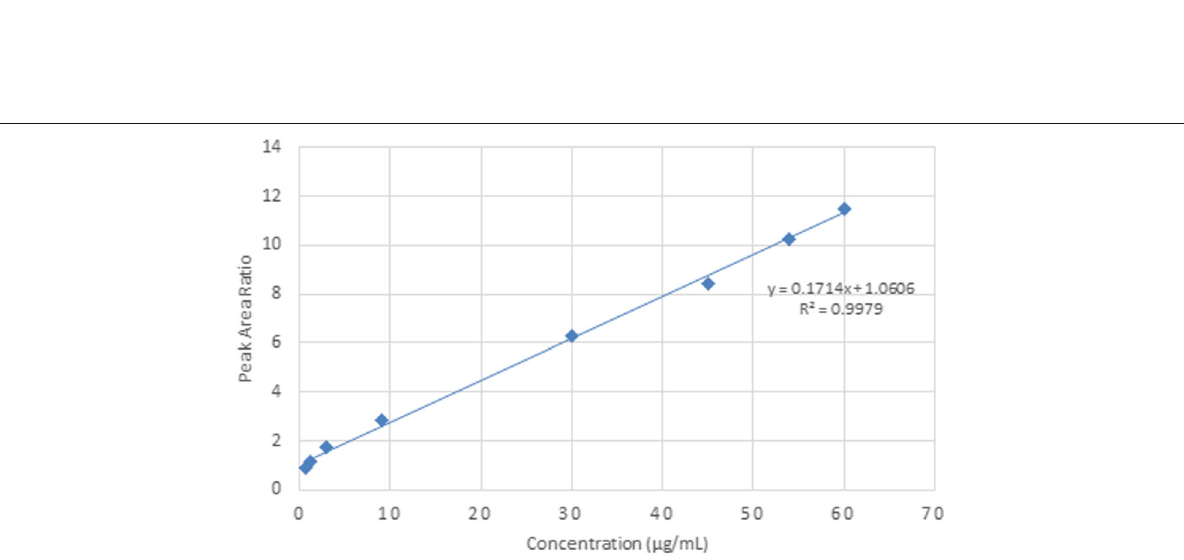
Fig. 6 Linearity curve of vitamin